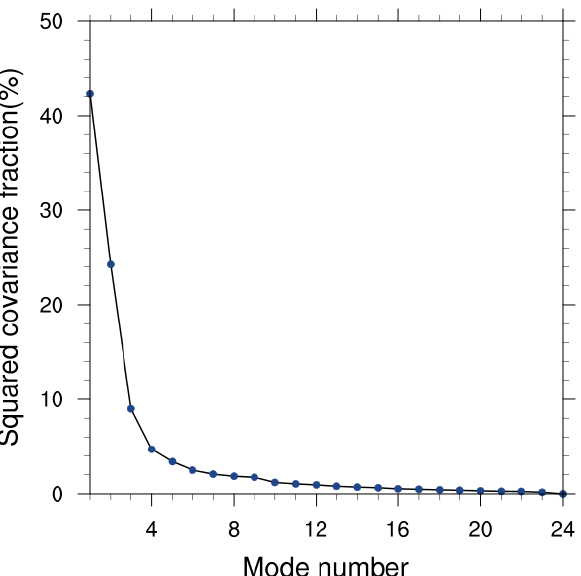
Figure 2. Variance contributions of the first 24 modes from the MEOF analysis of Ps.